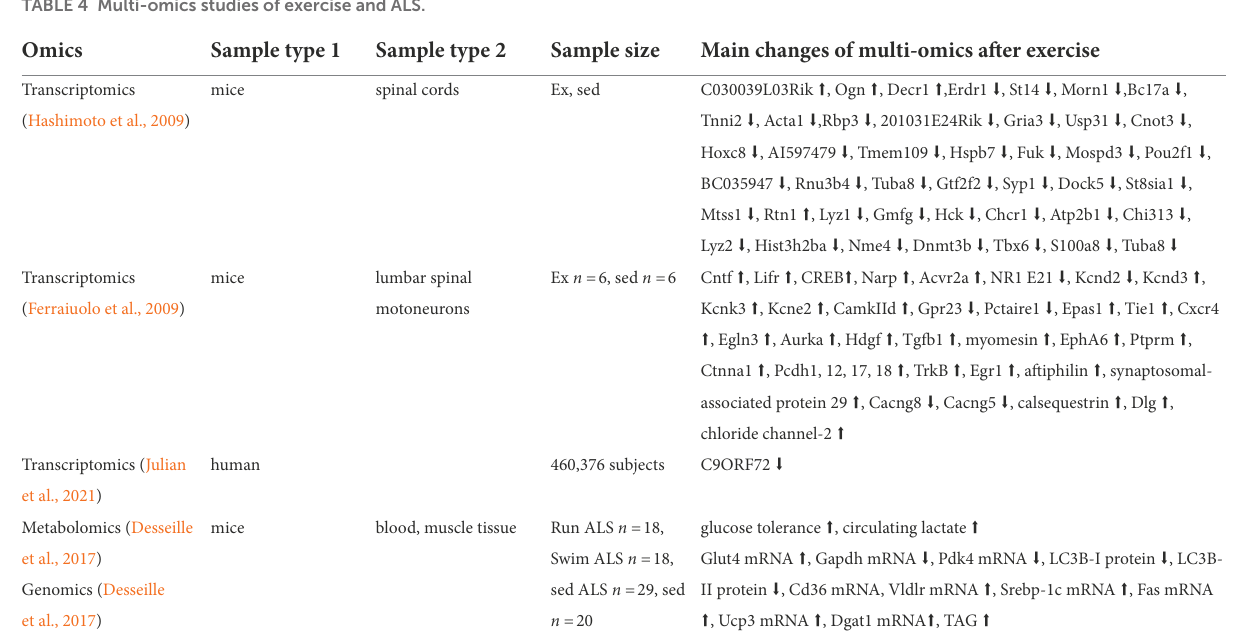
TABLE 4 Multi-omics studies of exercise and